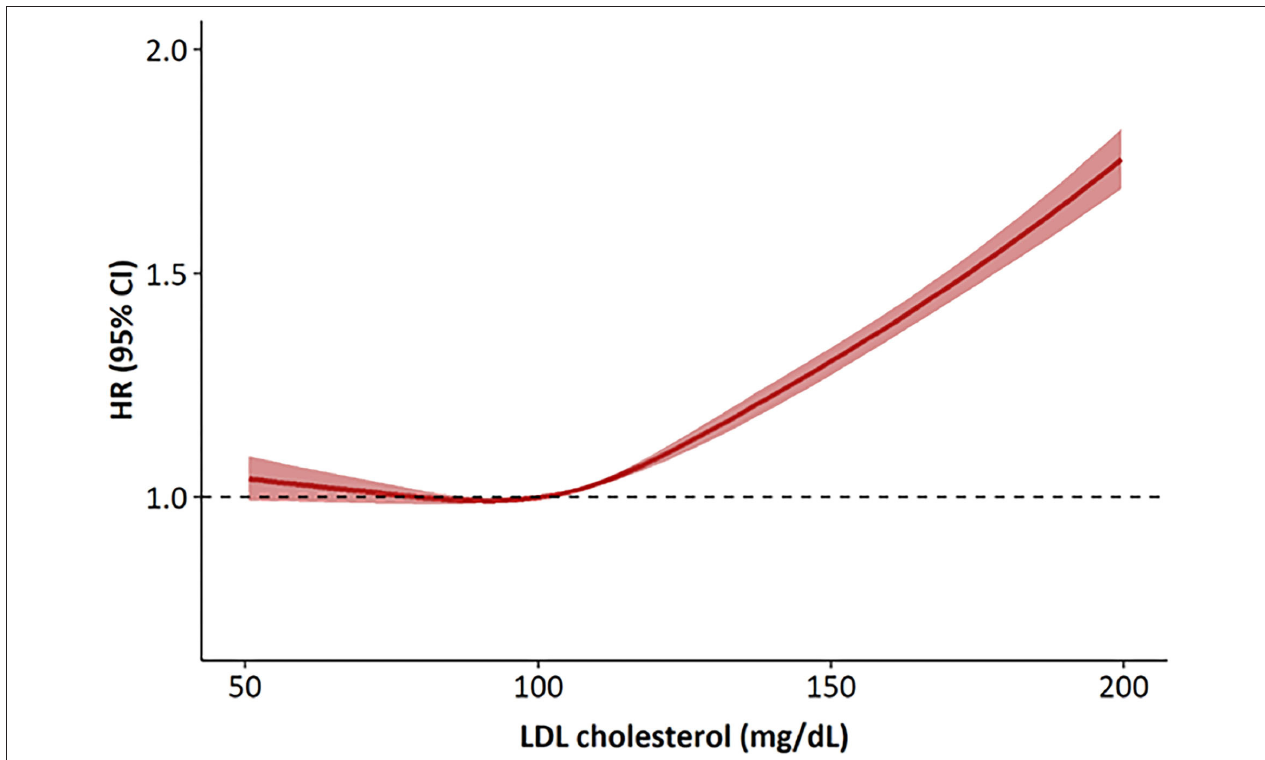
FIGURE 1 | Hazard ratios for cardiovascular disease according to LDL cholesterol levels at baseline. The hazard ratios were calculated by Cox models after adjusting for age, sex, body mass index, smoking status, alcohol consumption, regular exercise, income and the presence of hypertension. HR, hazard ratios.